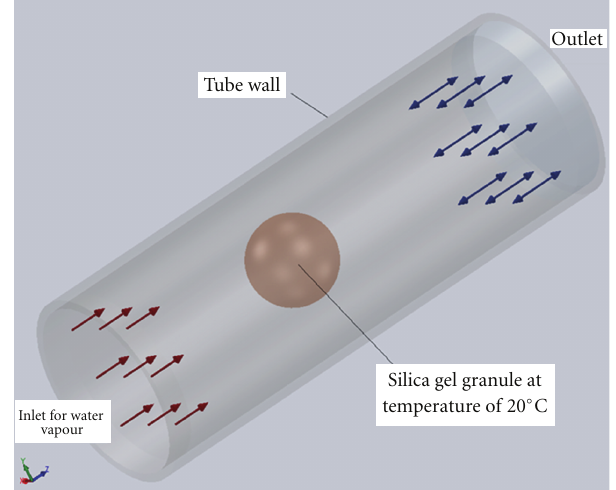
Figure 1: One silica gel in a tube geometry used for validation of CFD against theoretical models.